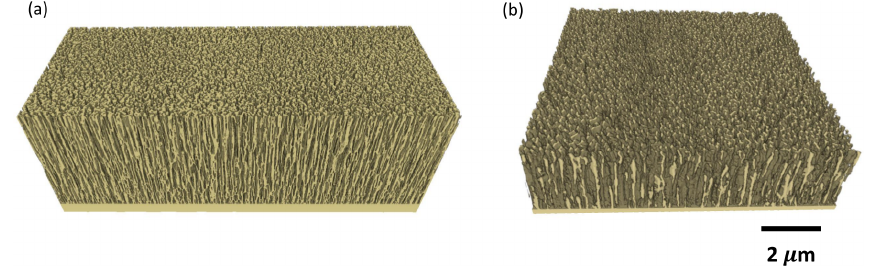
Figure 7. Volume renderings of the reconstructed Ta80 and Ta85 samples. (a) Ta80: 10µm × 4µm × 4µm. (b) Ta85: 6µm × 2µm ×